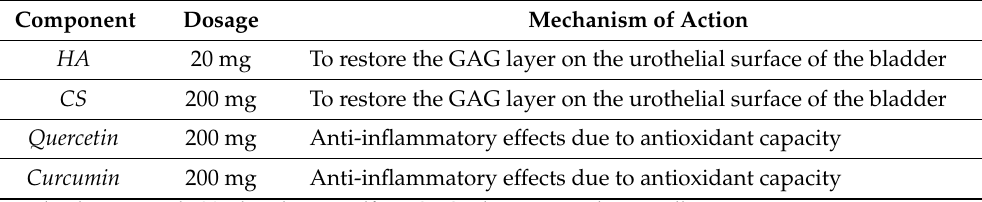
Table 6. Ialuril ® Soft Gels: components, dosages, and mechanisms of action. Component Dosage Mechanism of